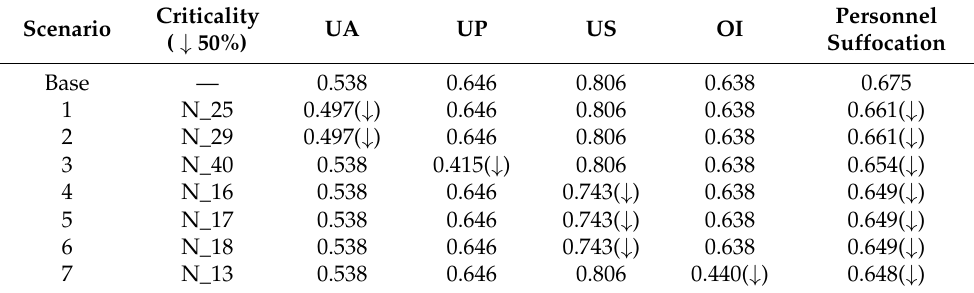
Table 8. Different scenarios for propagation analysis.